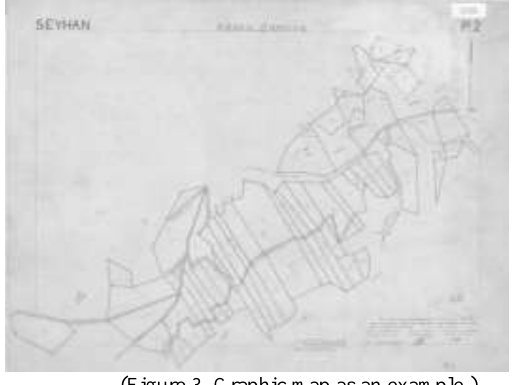
(Figure 3. Graphic map as an example.)